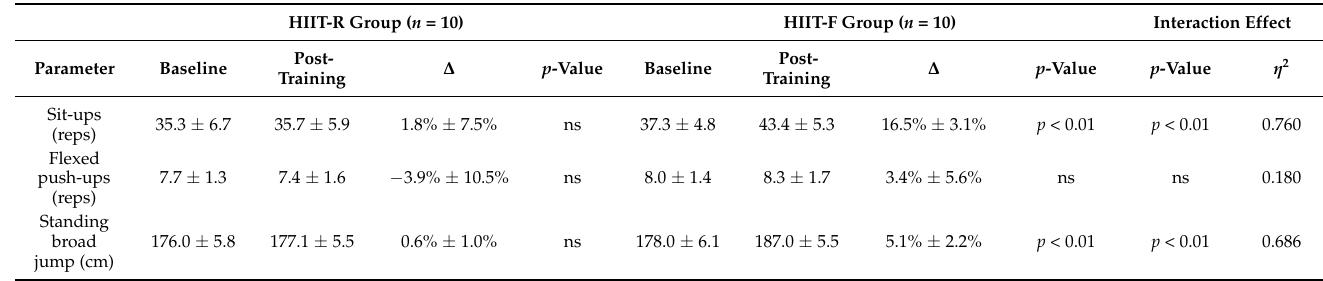
Table 4. Muscle performance data from HIIT-R and HIIT-F